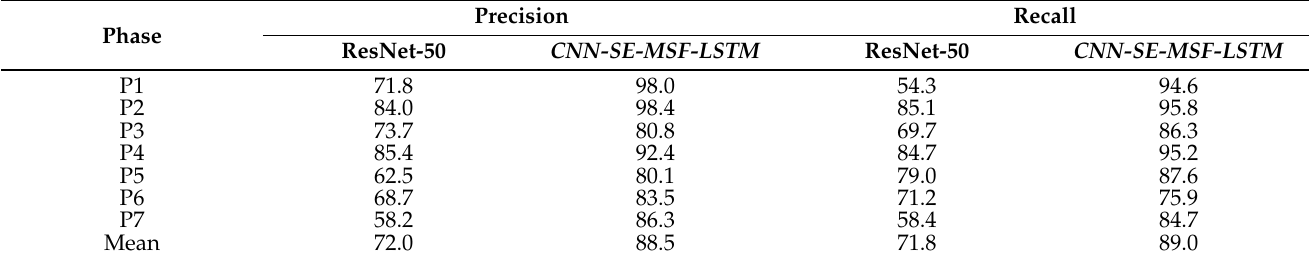
Table 4. Precision and recall of phase recognition results using the proposed approach on the Cholec80 dataset.